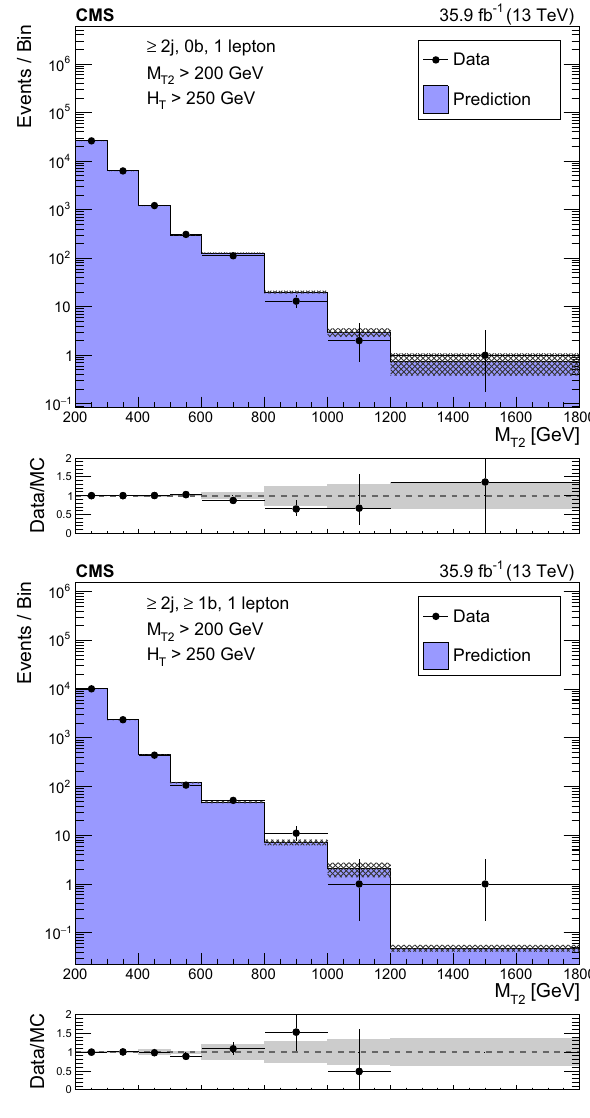
Fig. 1 Distributions of the M T2 variable in data and simulation for the single-lepton control region selection, after normalizing the simulation to data in the control region bins of H T , N j , and N b for events with no b-tagged jets (upper), and events with at least one b-tagged jet (lower). The hatched bands on the top panels show the MC statistical uncer- tainty, while the solid gray bands in the ratio plots show the systematic uncertainty in the M T2